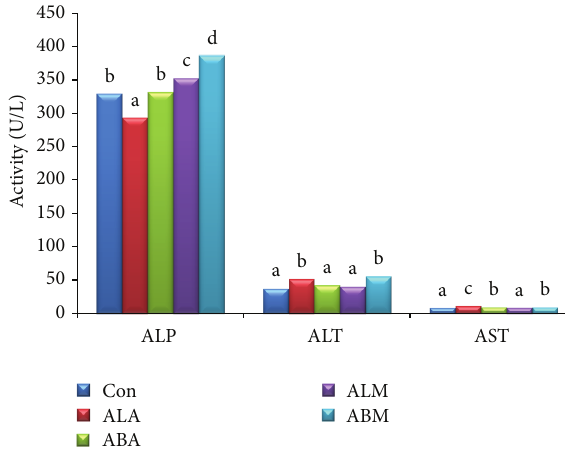
Figure 1: Serum hepatic enzymes levels of different groups (U L −1 ).